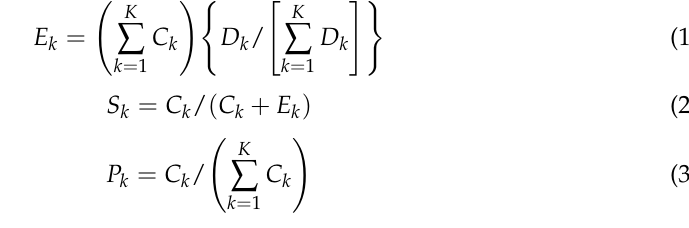
Table 1. Mathematical notation for Equations (1)–(3). Symbol Meaning k Identifier for an arbitrary category in the independent variable Number of categories in the independent variable